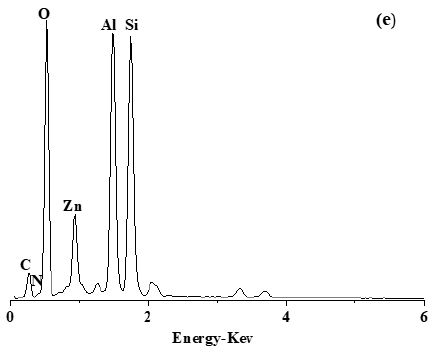
Figure 1. Scanning electron microscopy (SEM) images of ( a ) fly ash (FA) , ( b – d ) ZIF-8/FA composite and ( e ) energy dispersive spectrometer (EDS) of ZIF-8/FA composite.